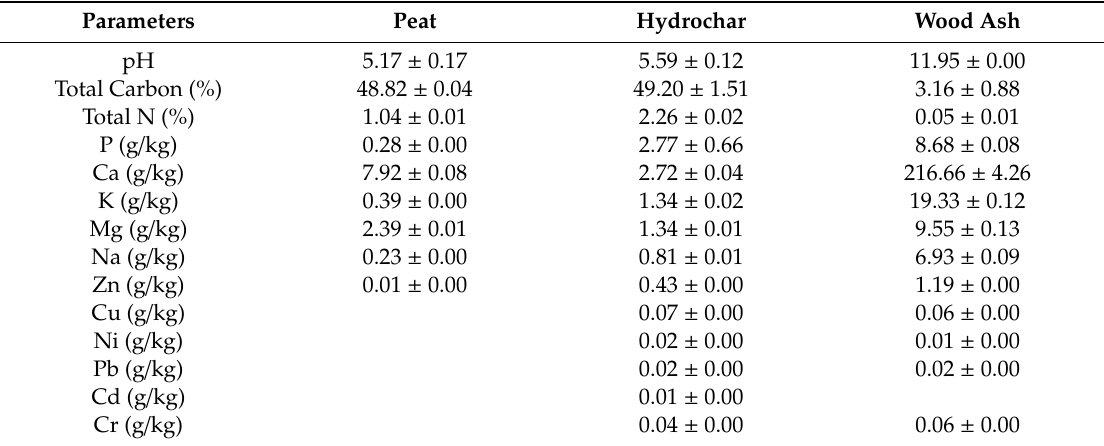
Table 1. The pH, nutrient and heavy metal concentrations of the peat, hydrochar and wood ash used in this